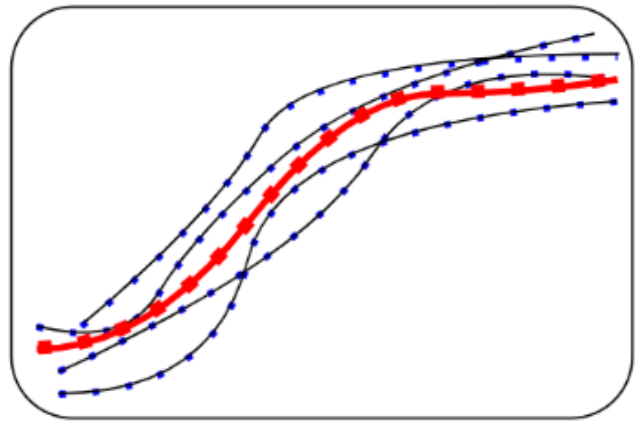
Figure 8. Cluster model.